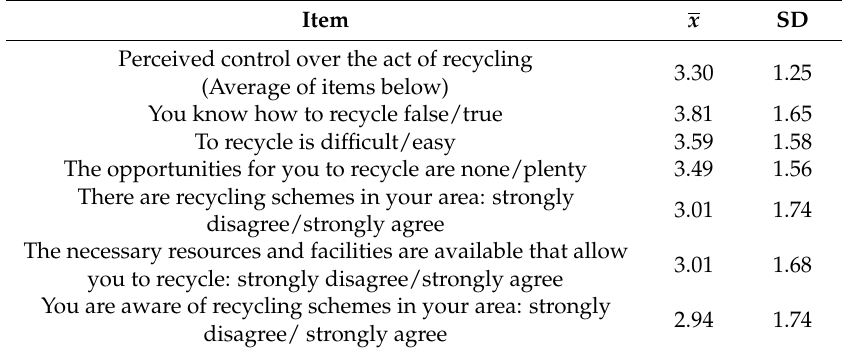
Table 6. Descriptive statistics for respondents’ perceived behavioral control over recycling